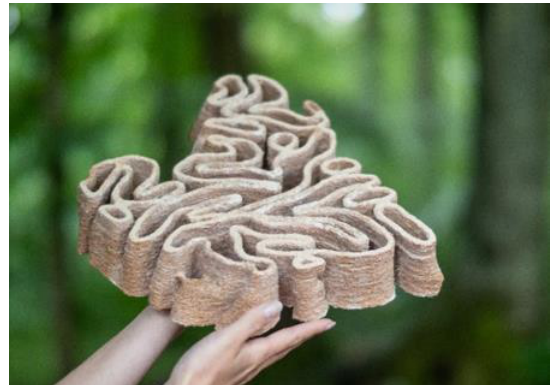
Figure 4. Printed subcomponent. Photo by author.